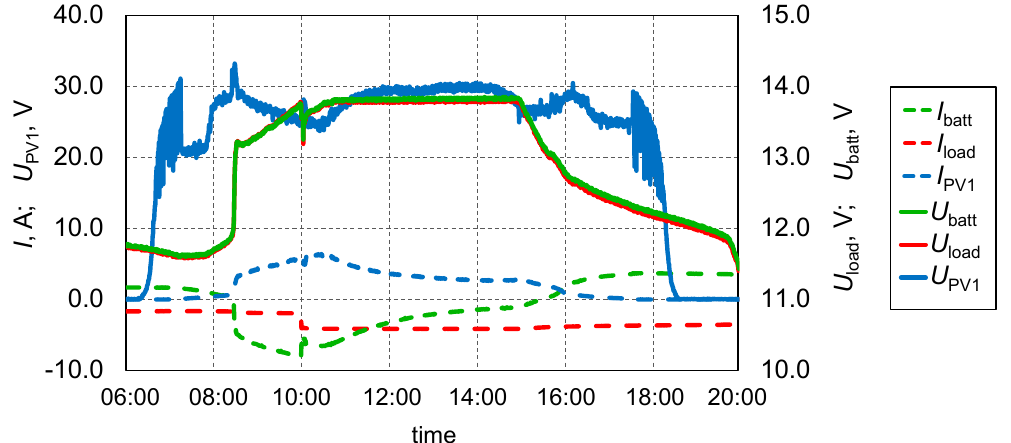
Figure 11. Current and voltage values in the PV-battery setup.